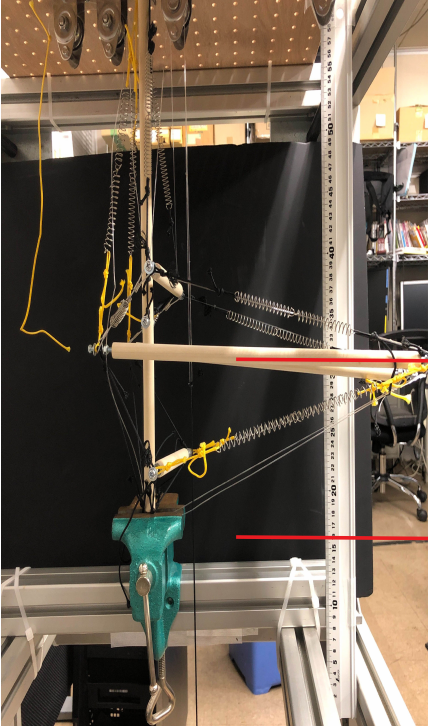
Figure 14. The lower arm is being pulled up with a weight of 5000 g. The upper red line is the height of the tip, and the lower red line is the initial height of the tip shown in Figure 10. The tip of the arm is pulled by a weight through the path of the pulley string shown in Figure 11.